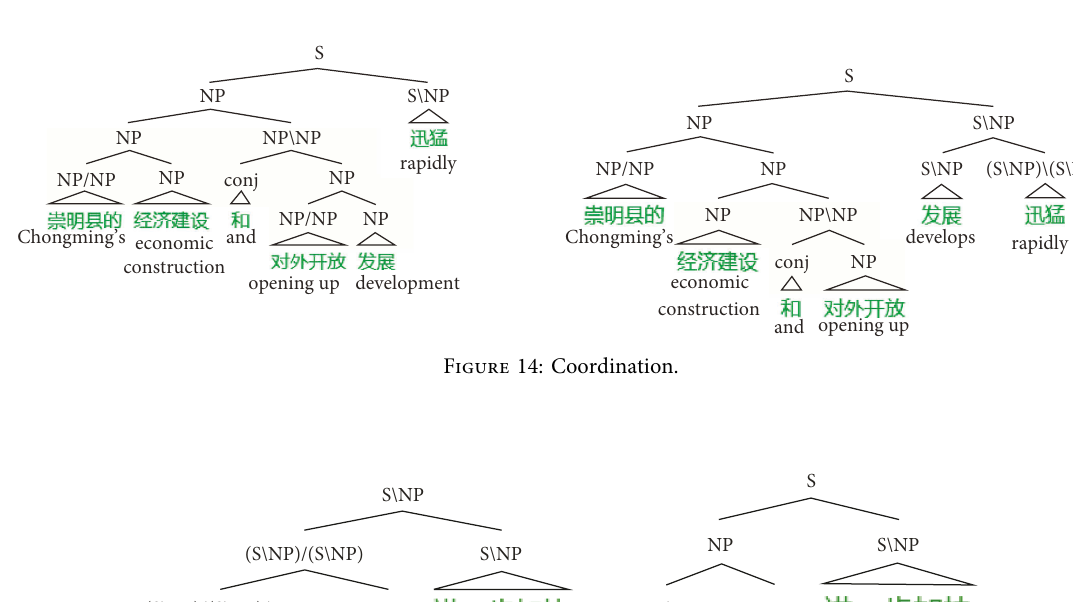
Figure 13: de construction.